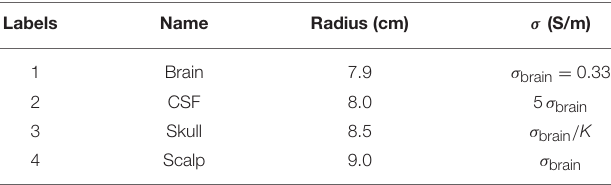
TABLE 1 | Radii and electrical conductivities of the present four-sphere